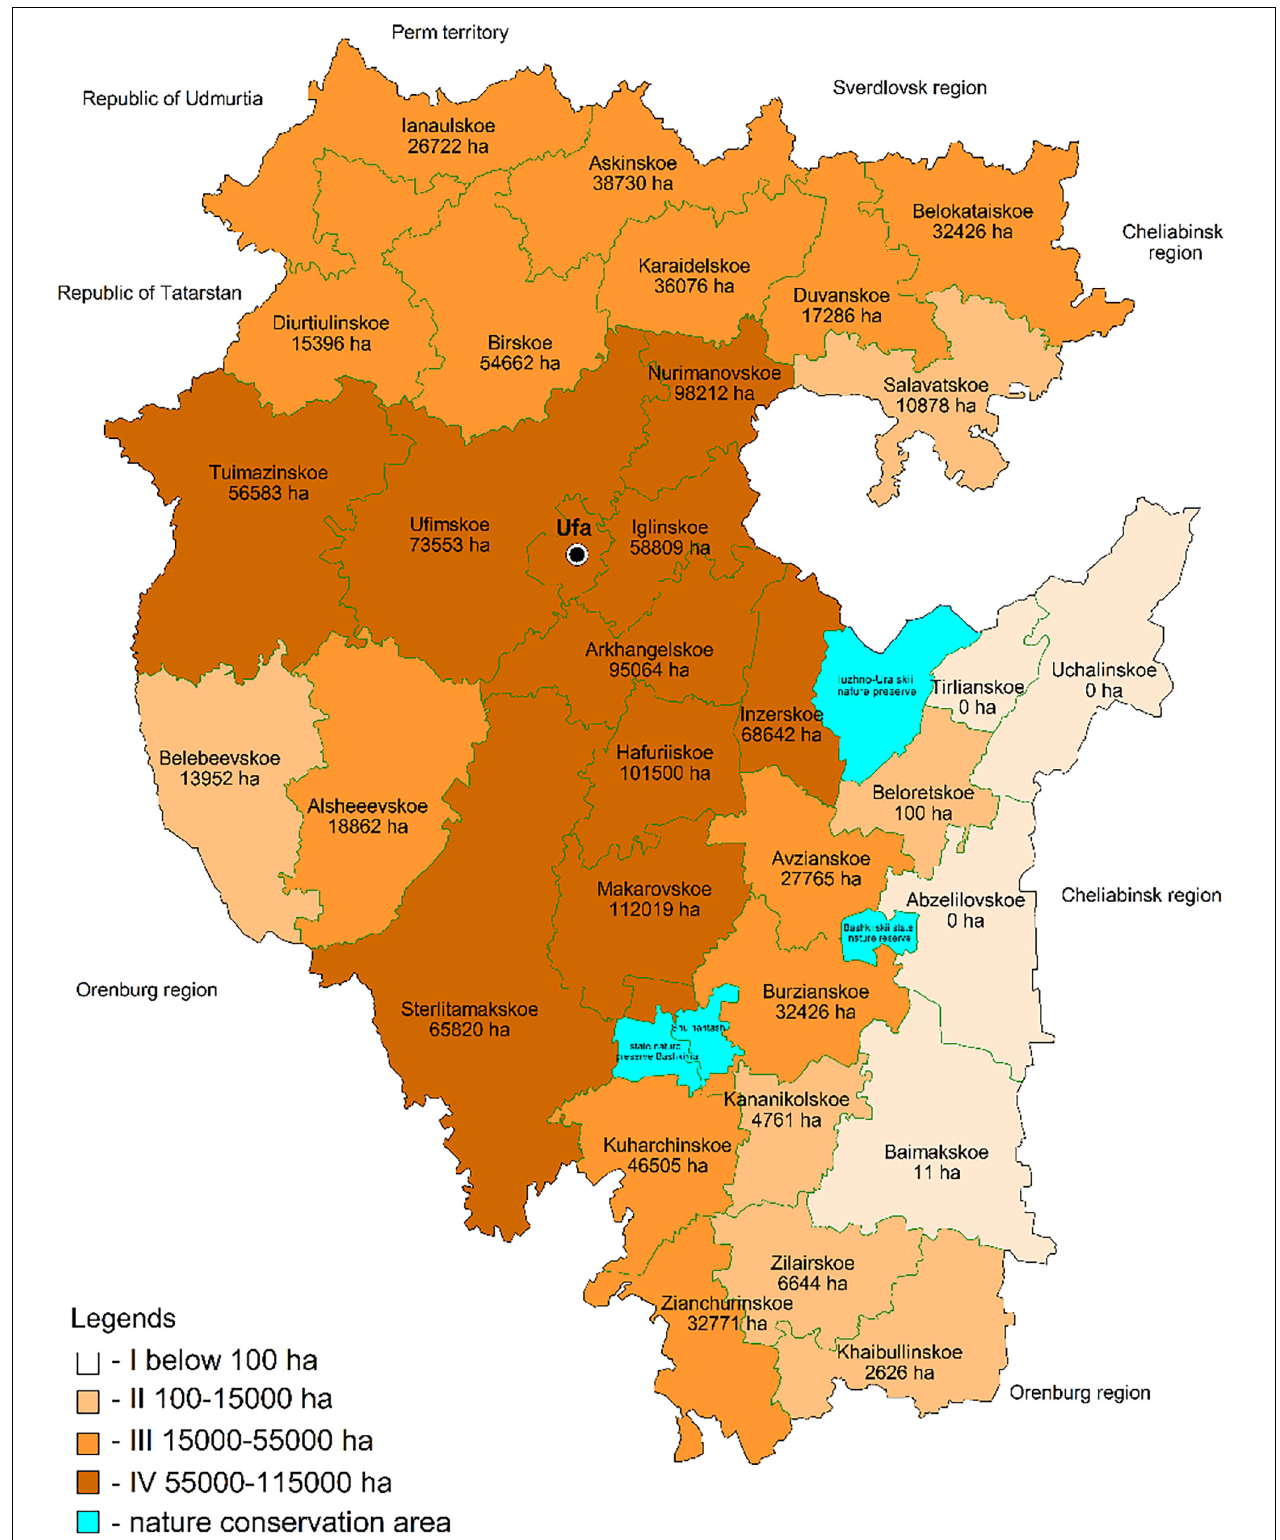
FIGURE 4 | Zoning of forest districts by the presence of lime trees in the forest composition.